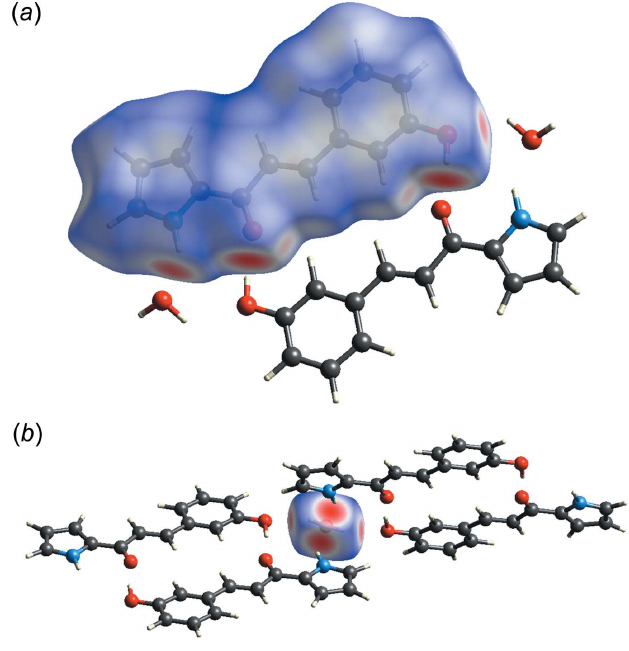
Figure 3 Three-dimensional Hirshfeld surfaces plotted over d norm in the range (cid:3) 0.667 to 1.118 a.u of ( a ) compound 3HPPP and ( b ) the water molecule, generated with Crystal Explorer (Spackman et al. , 2021).